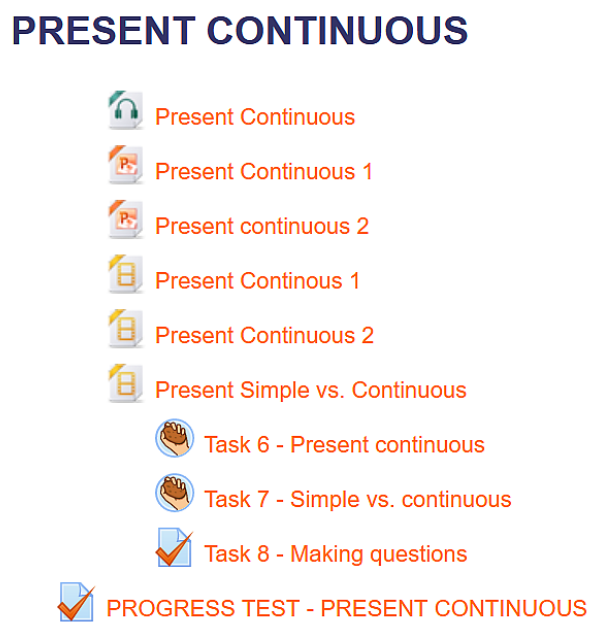
Figure 13. Student 6 sensory preferences: V + R + K. Figure 13. Student6 sensory preferences: V + R + K. Table 3. Comparison of values achieved in the didactic test by two students. If V5 value is in red, the category is marked “ not-completed ”, if in black, the category is marked “ completed ”. Bold font means at least a 10% better achieved